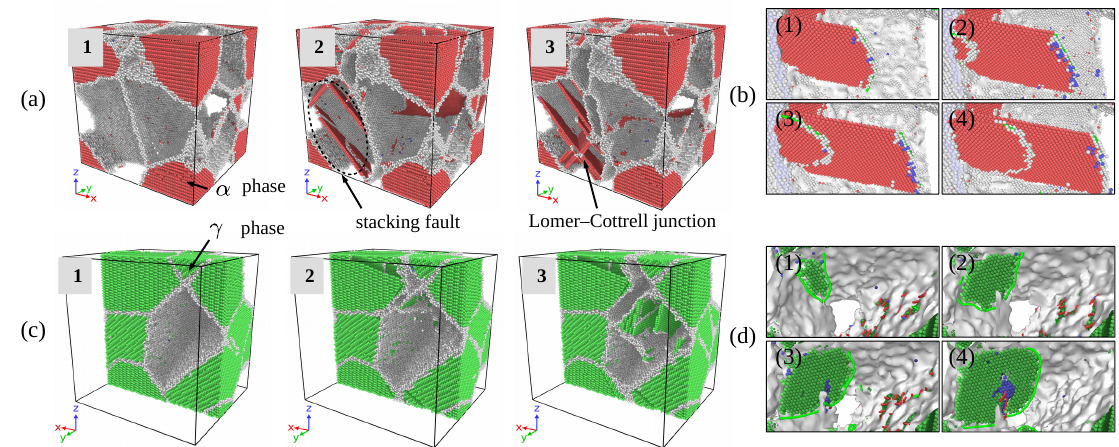
Figure 5. Microstructure evolution inside γ phase ( a , b ), α 2 phase ( c , d ) during yield stage.